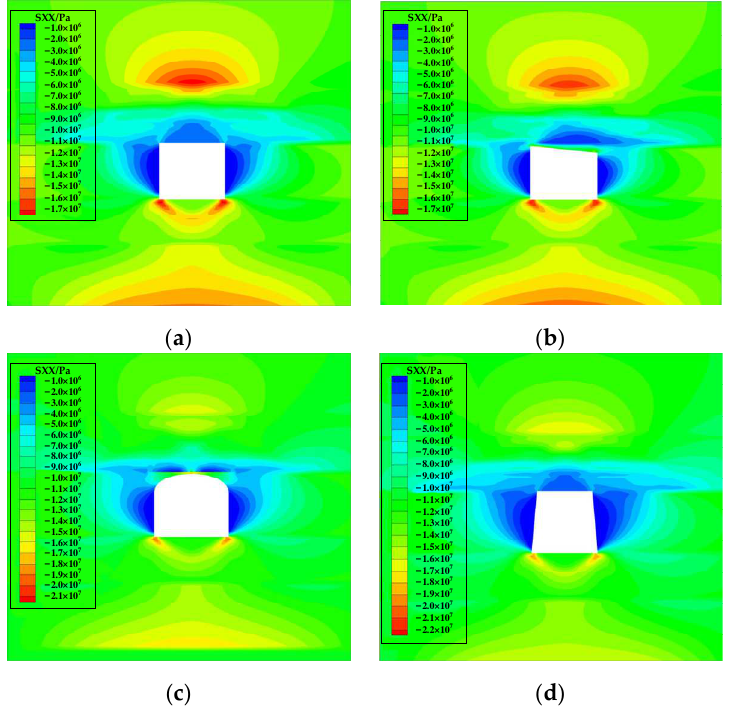
Figure 11. Horizontal stress distribution characteristics of surrounding rock in different channel section forms: ( a ) rectangle; ( b ) slanted-top rectangle; ( c ) straight-walled circular arch; ( d ) trapezoid.